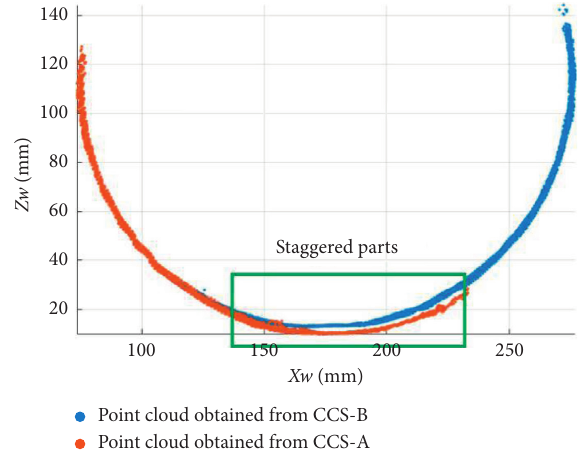
Figure 11: Visualization of point cloud stitching